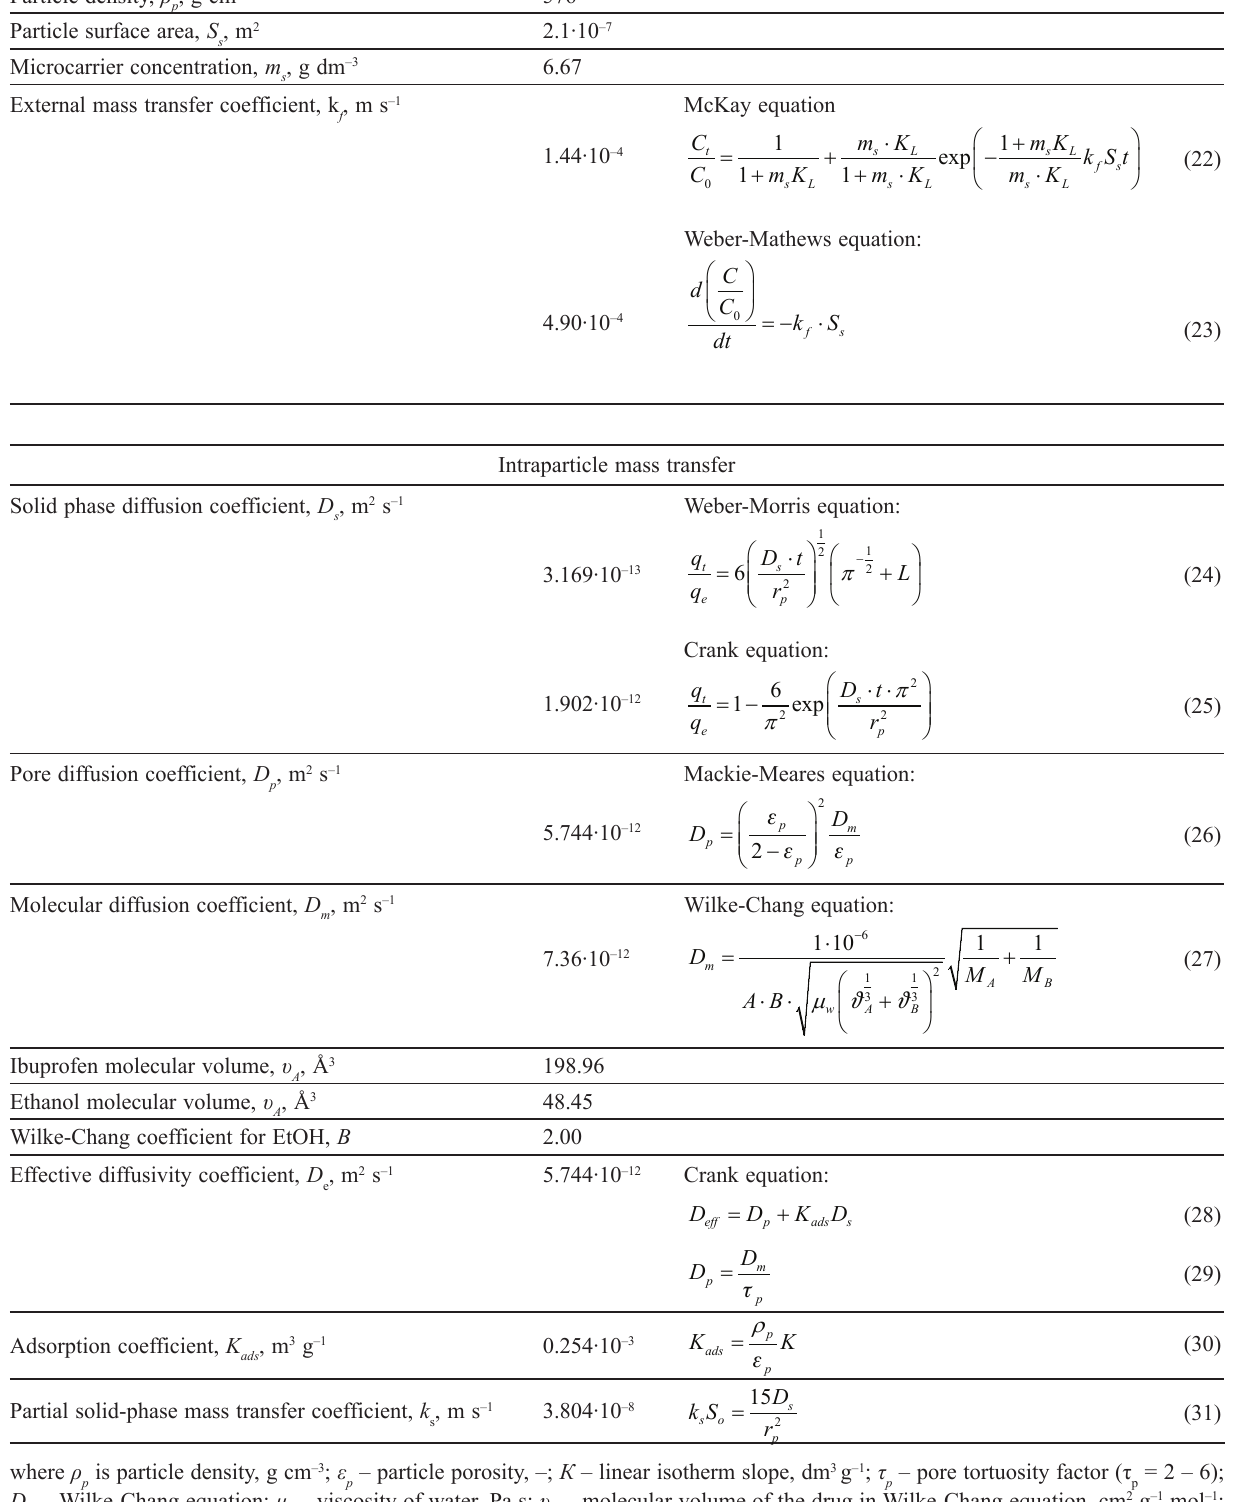
Table 6 – Values of the mass transfer and diffusion coefficients of IBU encapsulation Parameter Value Equation Particle porosity, ε , p